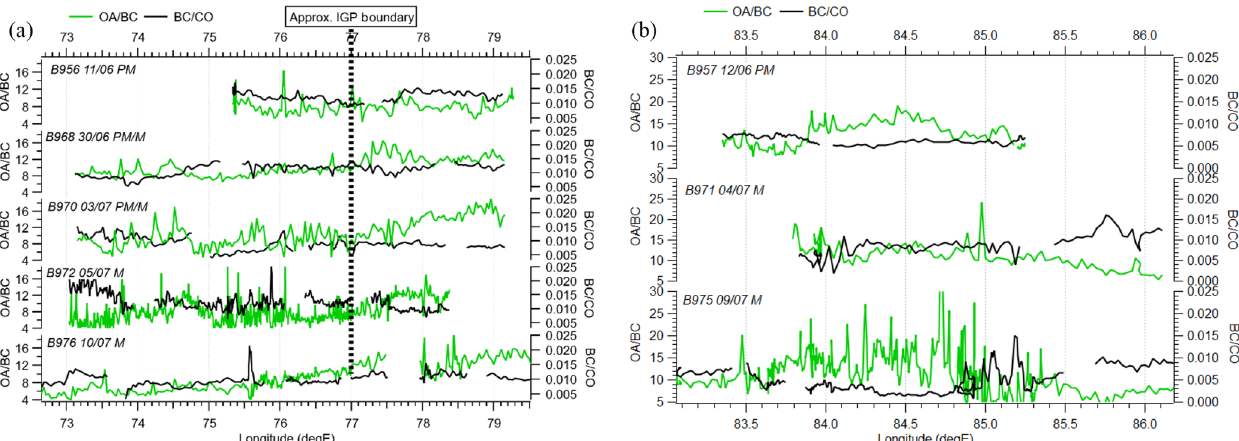
Figure 10. Horizontal spatial aerosol chemical composition (ratios of organics to black carbon, OA : BC, and black carbon to carbon monox- ide, BC : CO) for pre-monsoon (PM) and monsoon (M) seasons in northern India, from (a) Lucknow to Jaipur/Jodhpur and (b) from Lucknow to Bhubaneswar.